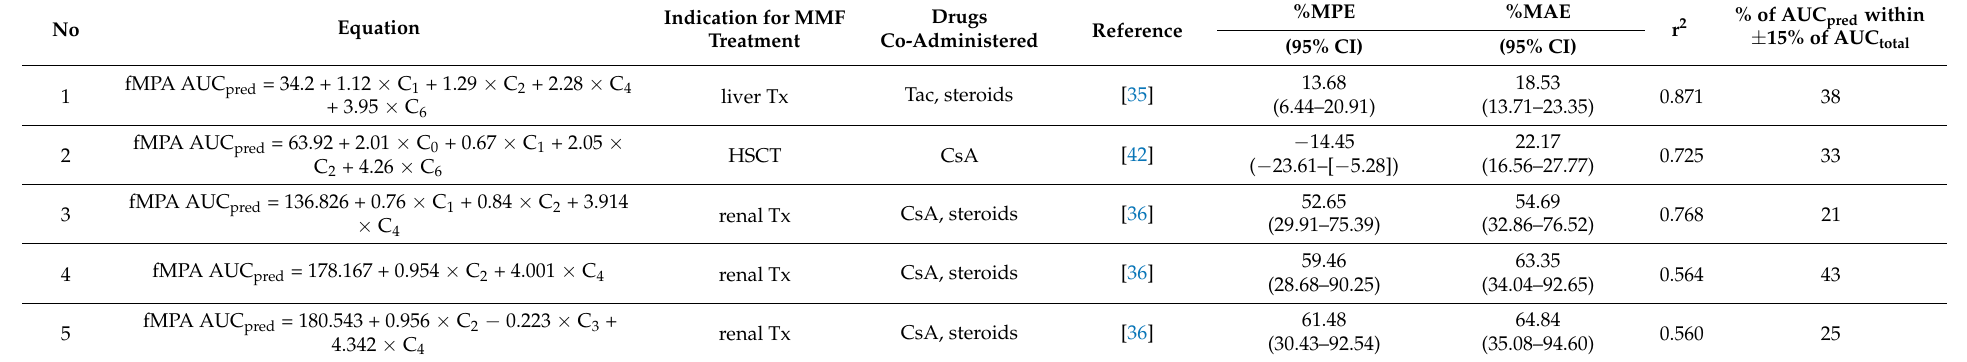
Table 4. The predictive performance of MLR-based HPLC-fMPA LSSs available in the literature for the estimation of fMPA AUC pred in children with nephrotic syndrome treated with